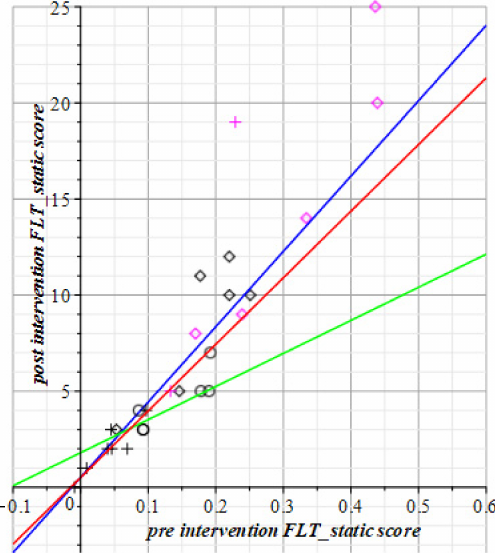
Figure 8. This depicts the results of the static FitLight ® s test in the number of hits per unit time interval. The + points are the control group (Red line); diamond points are the vision group (blue line); and circles are the motor group (green line). Both the visuo-spatial-motor and control group have an outlier. Red datapoints represent male subjects. Circles and green line: Motor group T 1 = 1.80 ( ± 1.09) +17.2 ( ± 7.4) T 0 . Rhombus pts., blue: Visuo-spatial-motor group, T 1 = 0.52 ( ± 1.59) + 39.2 ( ± 5.9) T 0 . Plus signs, red line: Control group, T 1 = 0.51 ( ± 1.14) + 34.7 ( ± 11.4) T 0